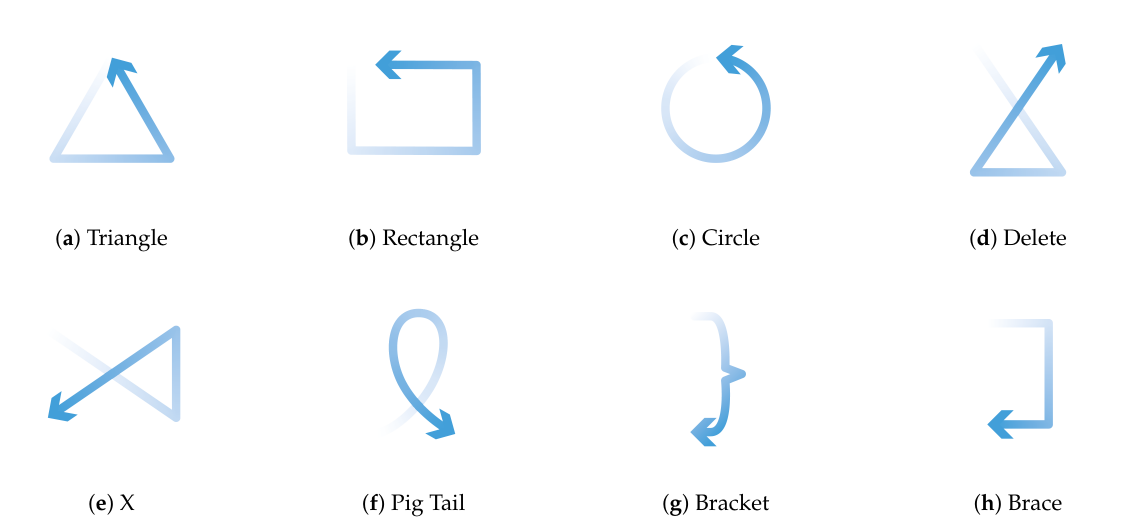
Figure 15. Unistroke gestures used for evaluation. The gestures start at the thin slightly transparent end and follow the direction of the arrow and end at the arrow.